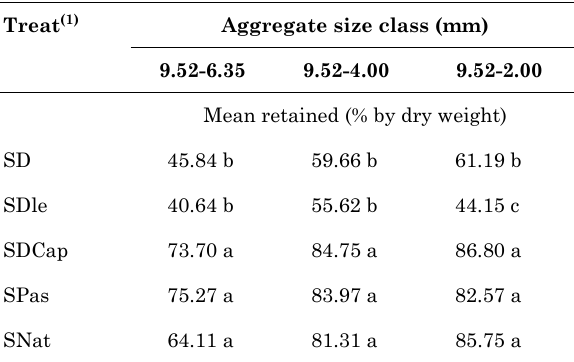
table 5. Mean values for the percentages by weight of aggregates stable under simulated rain for three size classes. Determinations